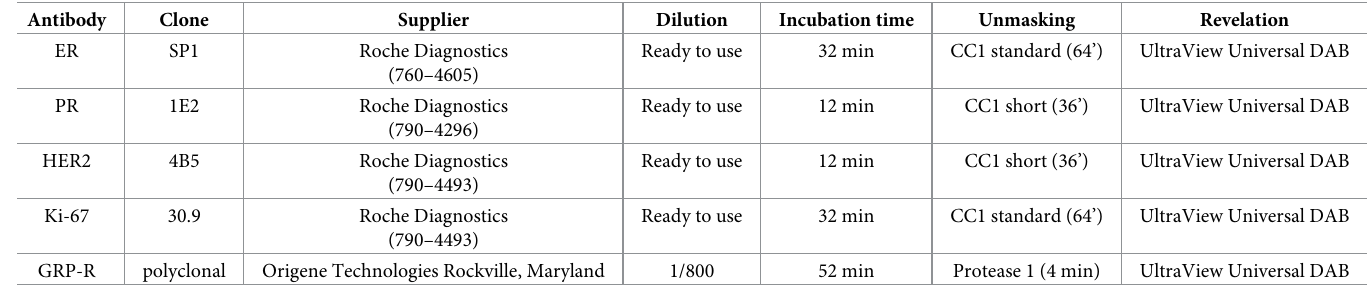
Table 2. Characteristics of antibodies used in this